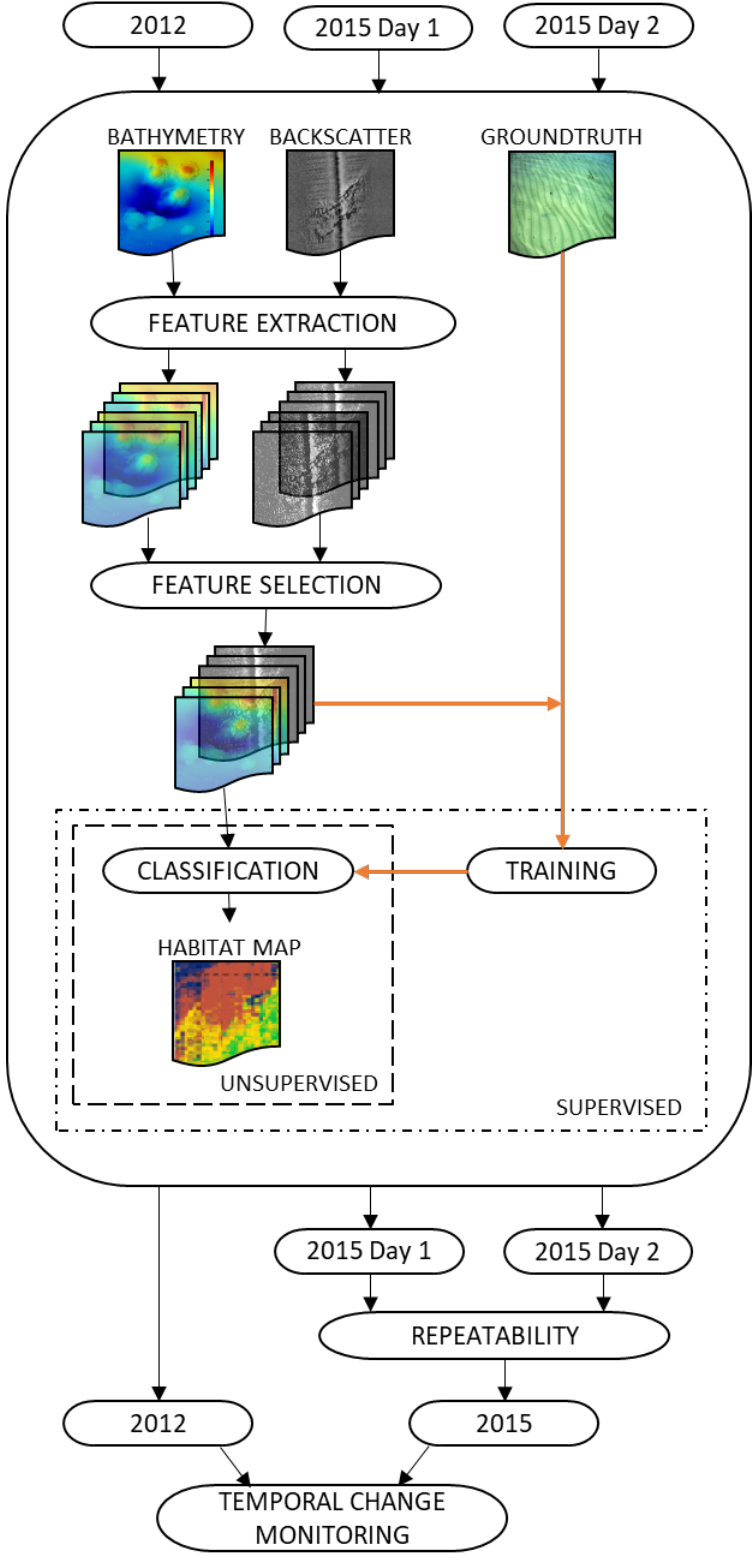
Figure 5. Flowchart summarising the automated seafloor classification and repeatability assessment .